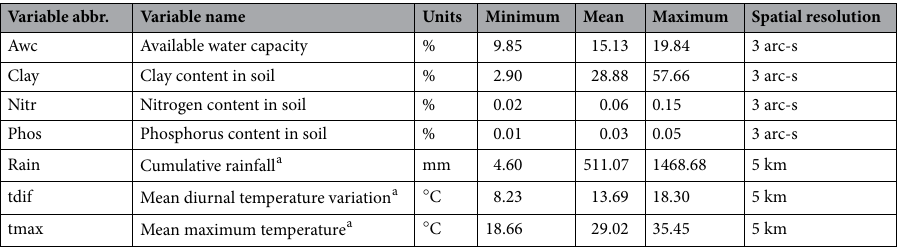
a 12 months prior to